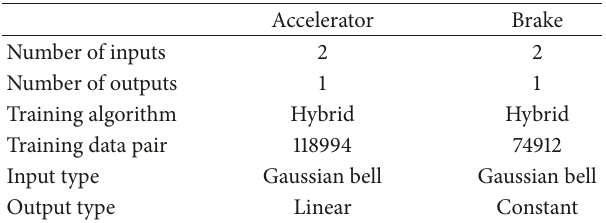
Table 3: PID gains. Table 4: ANFIS parameters.